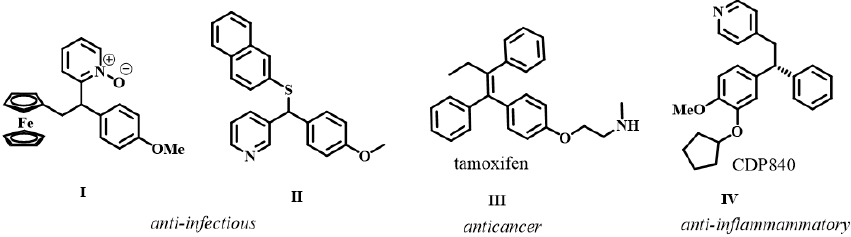
Figure 1. Examples of diarylmethane structures described in the literature with pharmacological properties.